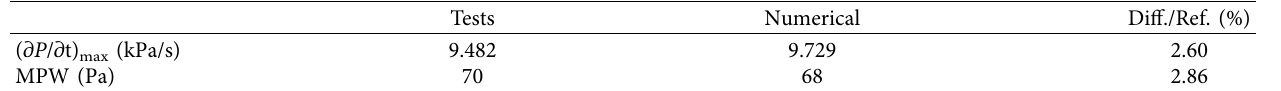
Table 2: Te maximum pressure gradient and the micropressure